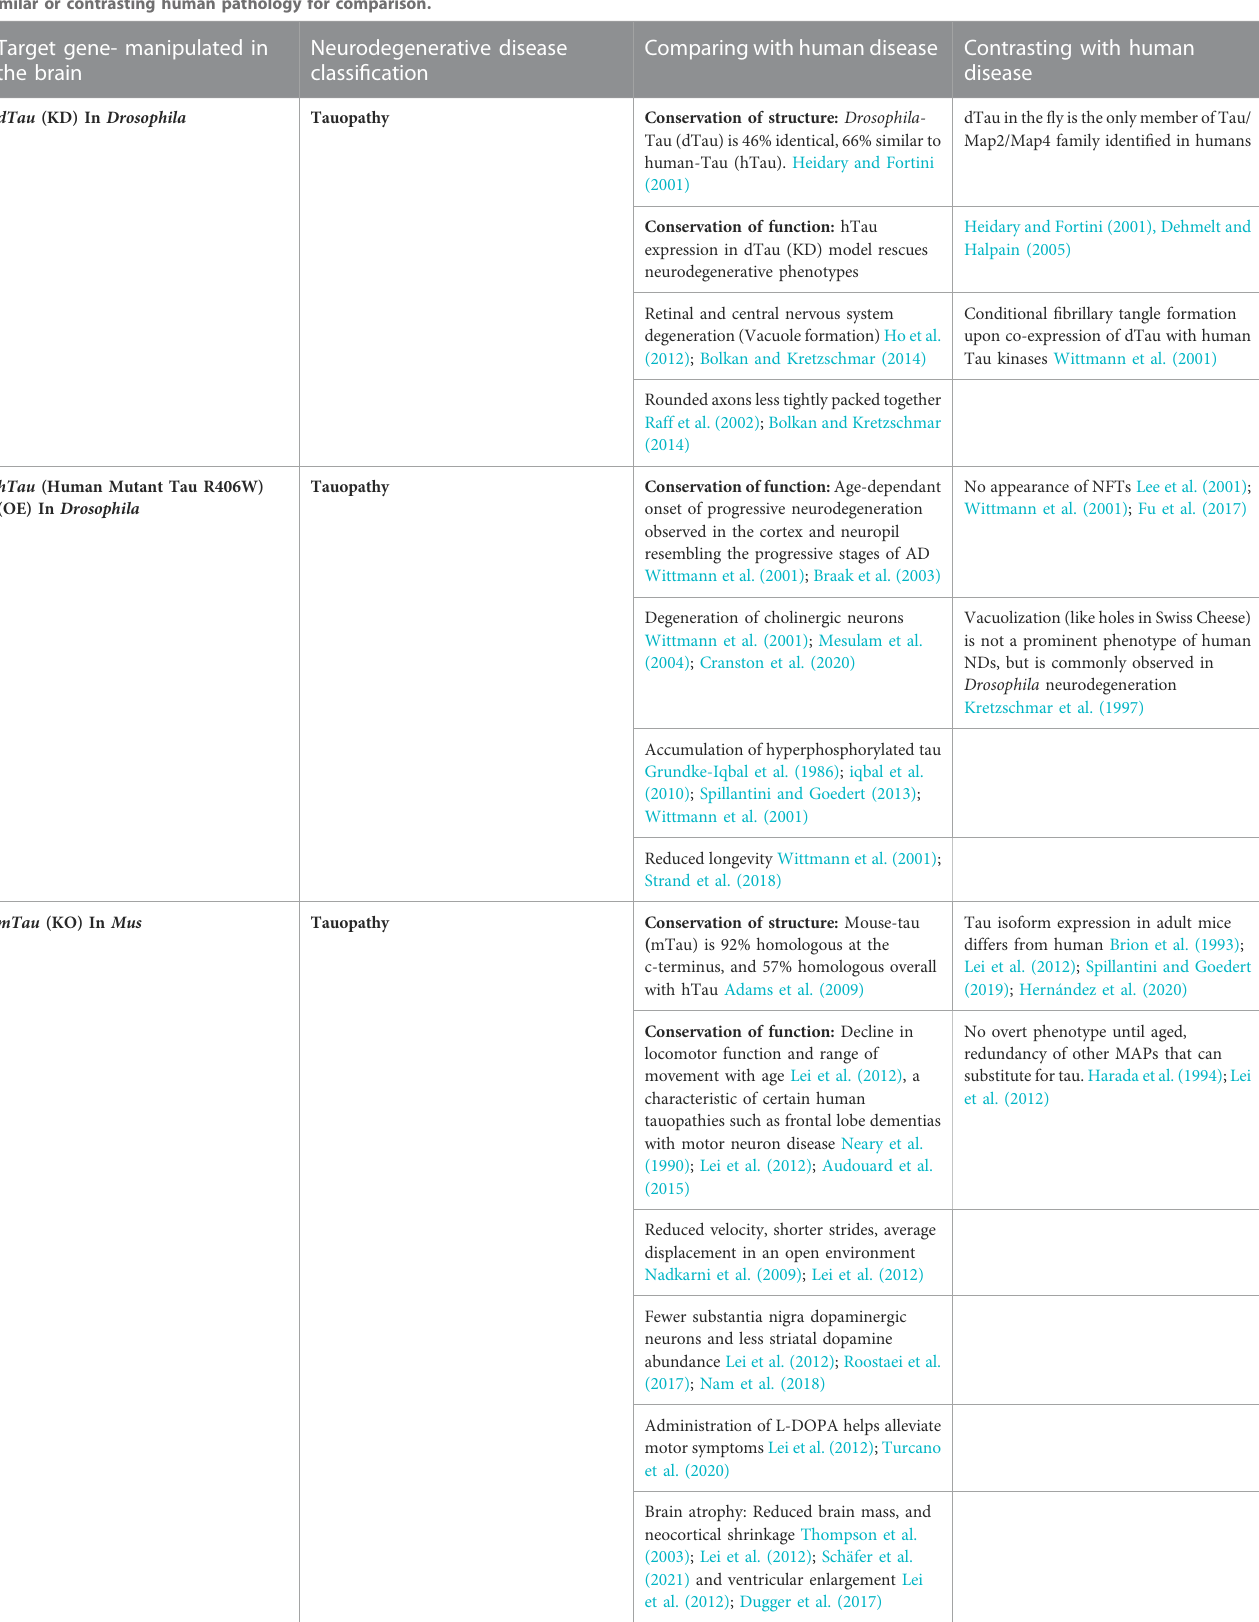
TABLE 1 Models of Mus musculus (Mouse) and Drosophila melanogaster (Fruit fl y) for studying the human neurodegenerative disease. The reported models represent Tauopathies, β -amyloidopathies, and Synucleinopathies in the brain. Models include Knock-out (KO), Knock-in (KI), Knock-Down (KD), and Over-Expression (OE) of hallmark genes for eachof the three categories of neurodegenerative disease listed above. There isa column describing similarities in pathology betweenspeciesand another column for differences. With each example made, there are references to the literature for more information about the model organism ’ s pathologies and similar or contrasting human pathology for